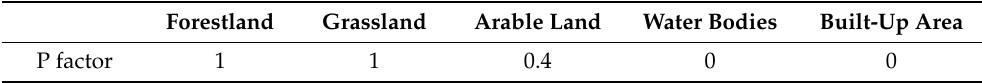
Table A2. Value for P factor under different land cover.